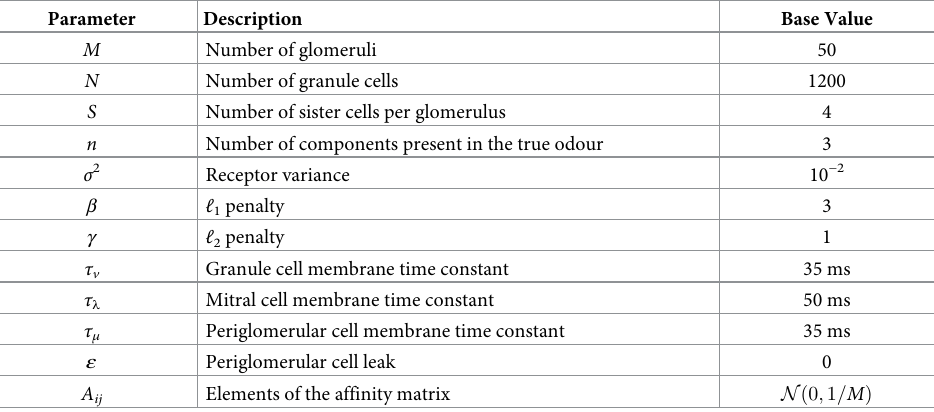
Table 1. Base parameters used in the